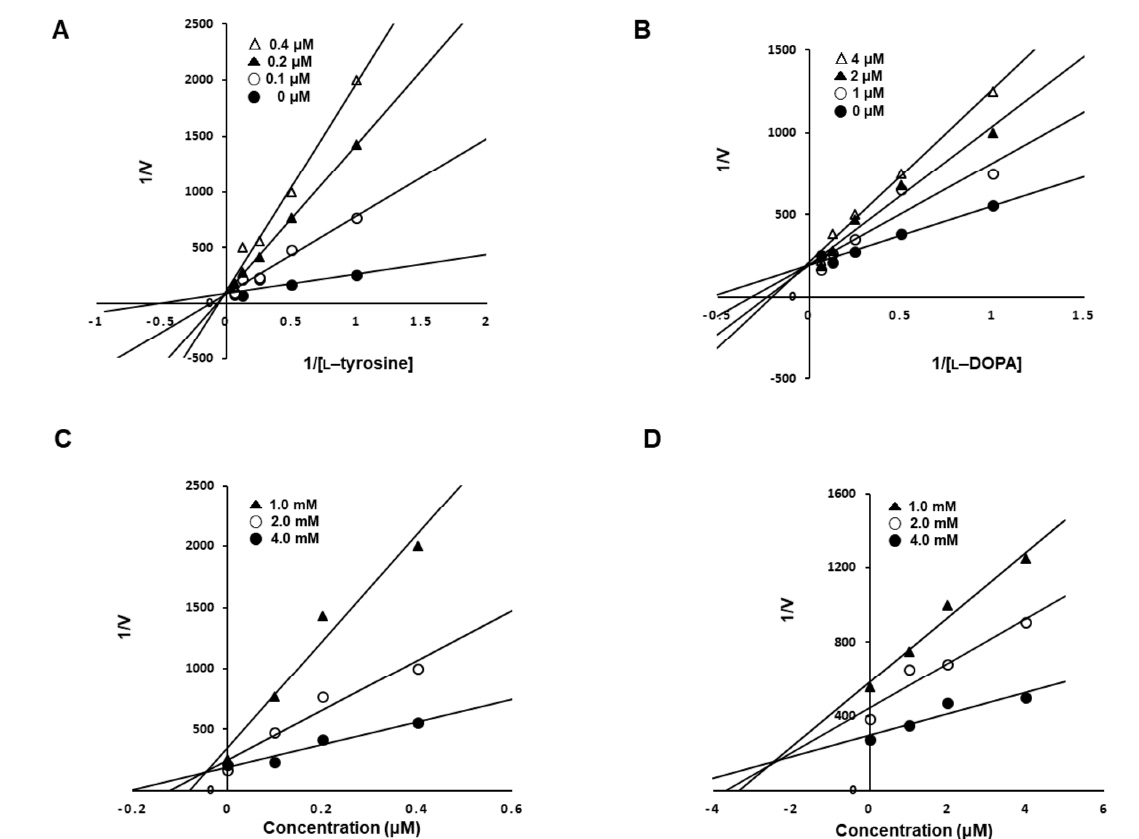
Figure 4. Kinetic study of compound 1b against mushroom tyrosinase using L -tyrosine ( A , C ) and L -DOPA ( B , D ). Lineweaver–Burk plots ( A , B ) for the inhibition of tyrosinase by 1b (0, 0.1, 0.2, or 0.4 μ M in A, and 0, 1, 2, or 4 μ M in B) in the presence of L -tyrosine ( A ) or L -DOPA ( B ) as substrates. Dixon plots ( C , D ) for the inhibition of tyrosinase by 1b in the presence of L -tyrosine (0.25, 0.5, or 1.0 mM in C) or L -DOPA (0.25, 0.5, and 1.0 mM in D), respectively. Data in A and B are represent 1/V values (defined as the inverse of the rate of increase in absorbance at 475 nm) at five different L -tyrosine concentrations (1, 2, 4, 8, and 16 mM). Data in C and D are also mean 1/V values at four different concentrations (0, 0.1, 0.2, and 0.4 μ M in C, and 0, 1, 2, and 4 μ M in D) of 1b .